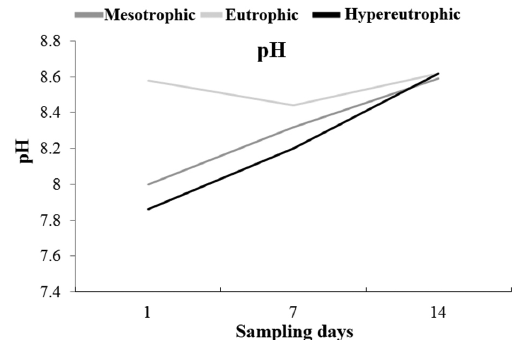
Figure 2. Temporal variations of pH on three experi- mentally simulated trophic conditions (mesotrophic, eutrophic and